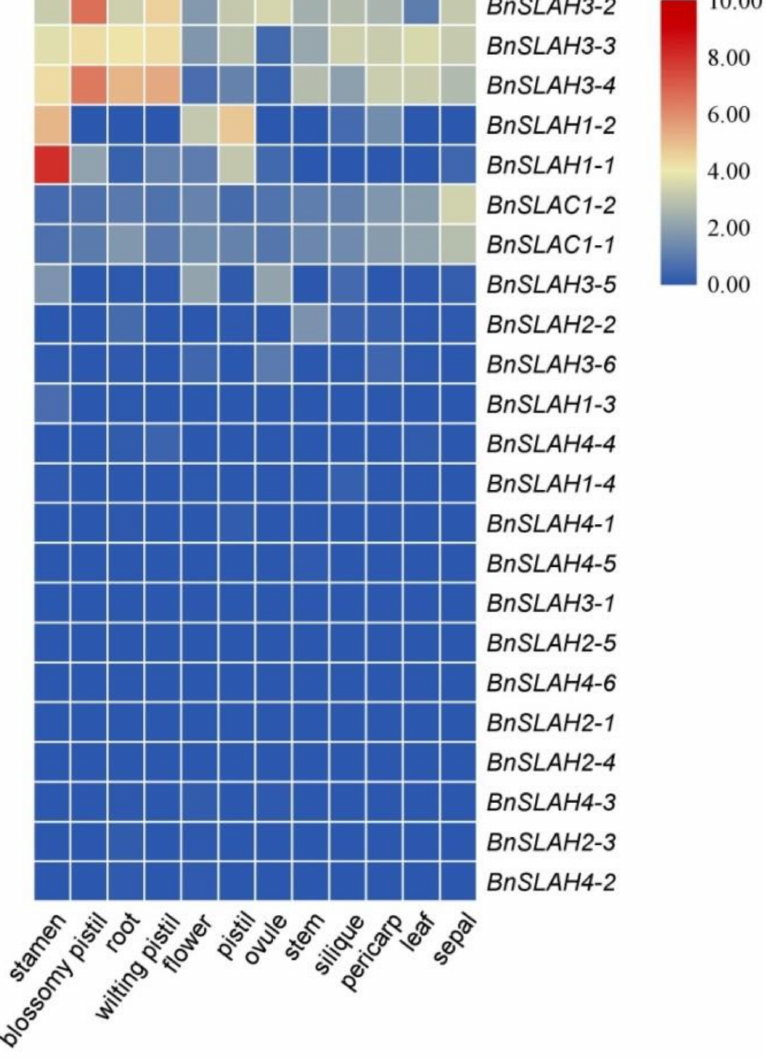
Figure 7. Expression patterns of BnSLAC/SLAH family genes in twelve tissues. The expression data were gained from the RNA-seq data and calculated by fragments per kilobase of exon model per million (FPKM) values. The label above the heatmap represents the different tissues of B. napus ZS11, the right side of the heatmap represents different BnSLAC/SLAH genes. The colour bar represents log 2 FPKM